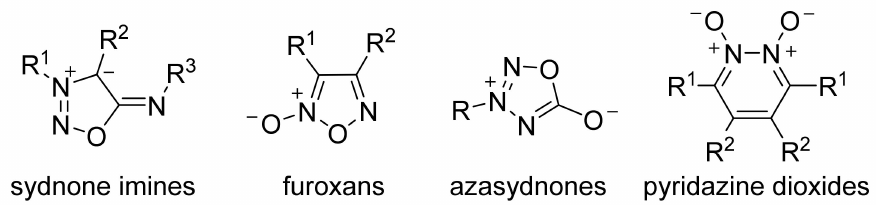
Figure 1. Structures of heterocyclic NO-donors presented in this